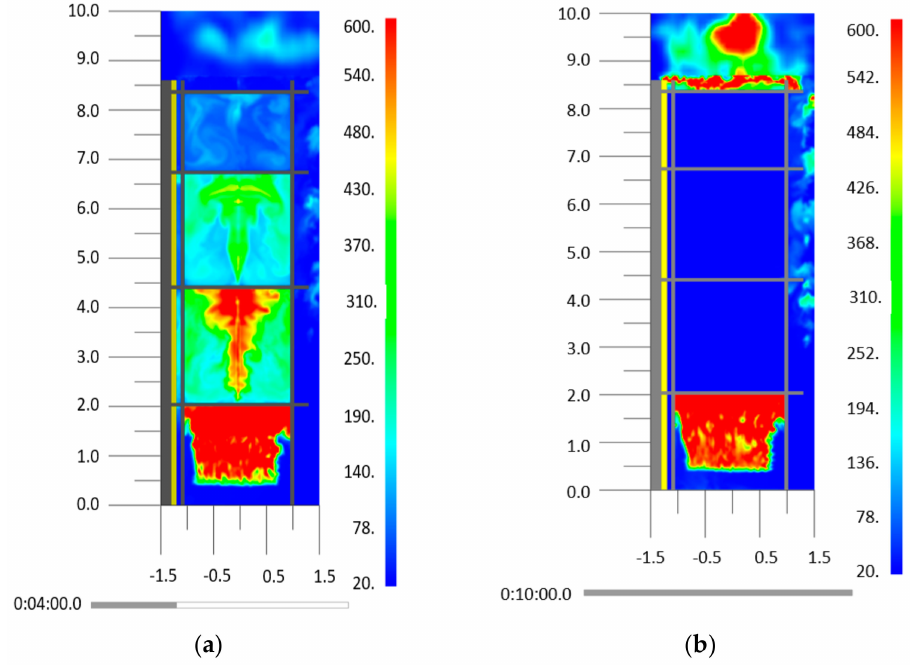
Figure 14. Air-cavity temperature distribution for gap and no-gap scenarios. ( a ) S1 model with ACP gaps, ( b ) S5 model with no ACP